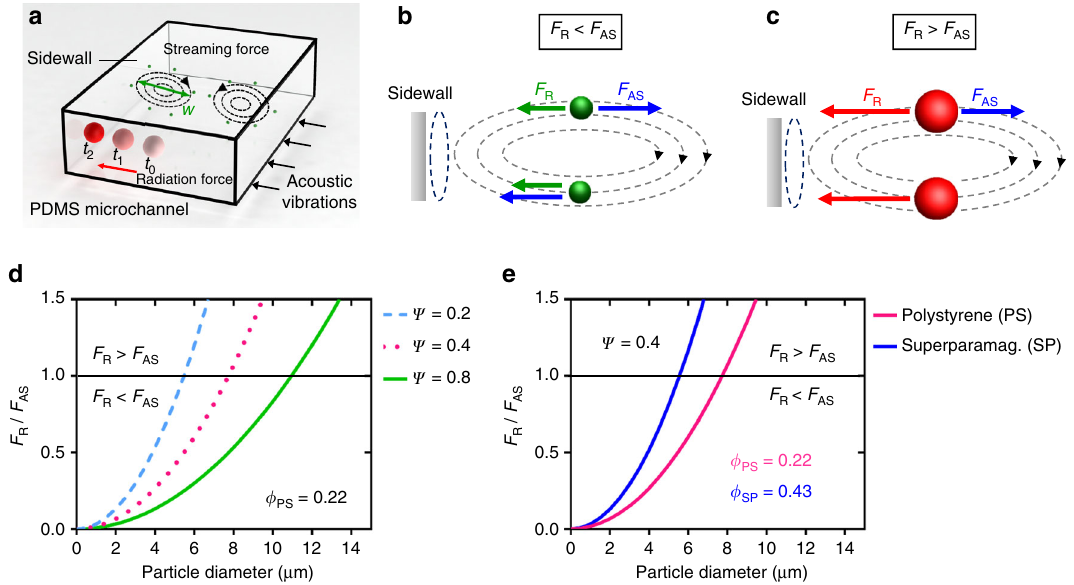
Fig. 2 Analysis of particle trapping. a A schematic demonstrates the radiation force ( F R ) and the sidewall-induced streaming drag ( F AS ) that act on different sized particles. Large particles, which are illustrated in red , migrate to the channel sidewall by the radiation force. Small particles, which are shown in green , follow sidewall-induced streaming. b For a particle with a diameter a < a c , the acoustic streaming force dominates. c For a particle with a diameter a > a c , the acoustic radiation force dominates. d The plot shows the ratio of the acoustic radiation to streaming forces vs. different size polystyrene particle for various geometry factor, Ψ . Above the black line , F R > F AS , i.e. radiation force dominates and below the line , F R < F AS , i.e. streaming dominates. e The plot demonstrates the competing forces of the polystyrene ( PS ) and the superparamagnetic particles ( SP ) at Ψ